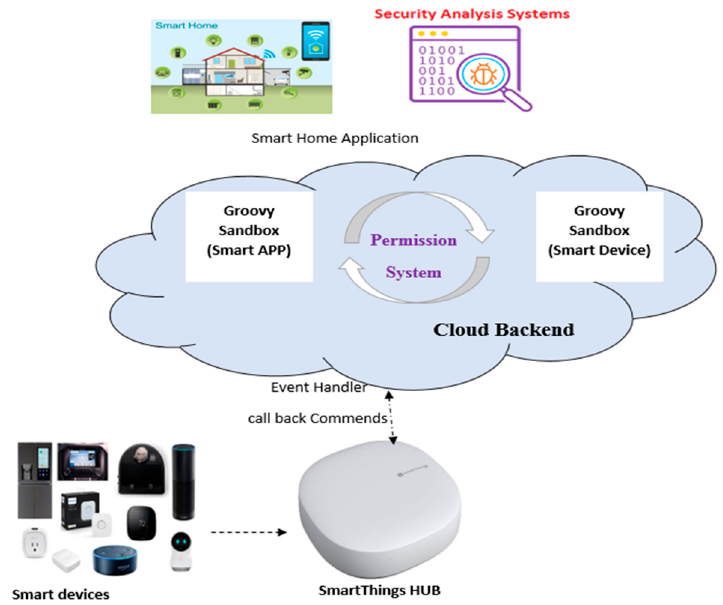
Figure 2. SmartThings Platform Architecture.